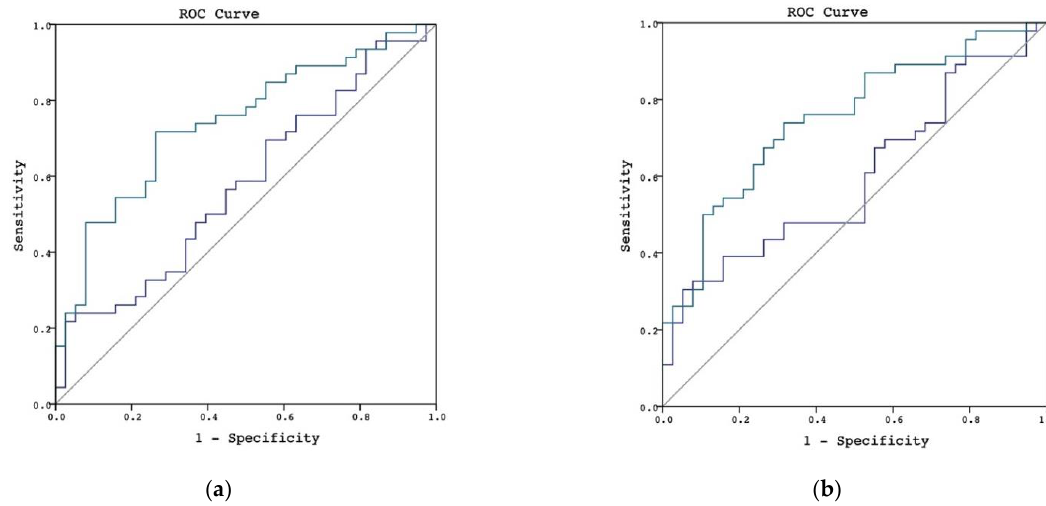
Figure 2. AUROC in discriminating postoperative AKI in patients with CPB durations longer than 120 min. ( a ) L-FABP in discriminating postoperative AKI in patients with CPB durations longer than 120 min, the urinary L-FABP at the first timepoint is shown by the blue line and the L-FABP at the second timepoint is shown by the green line. ( b ) L-FABP/creatinine ratio in discriminating postoperative AKI in patients with CPB durations longer than 120 min, the urinary L-FABP/creatinine ratio at the first timepoint is shown by the blue line and the L-FABP/creatinine ratio at the second timepoint is shown by the green line. Table 3. Urinary L-FABP and urinary L-FABP-to-creatinine ratio performance in discriminating AKI.